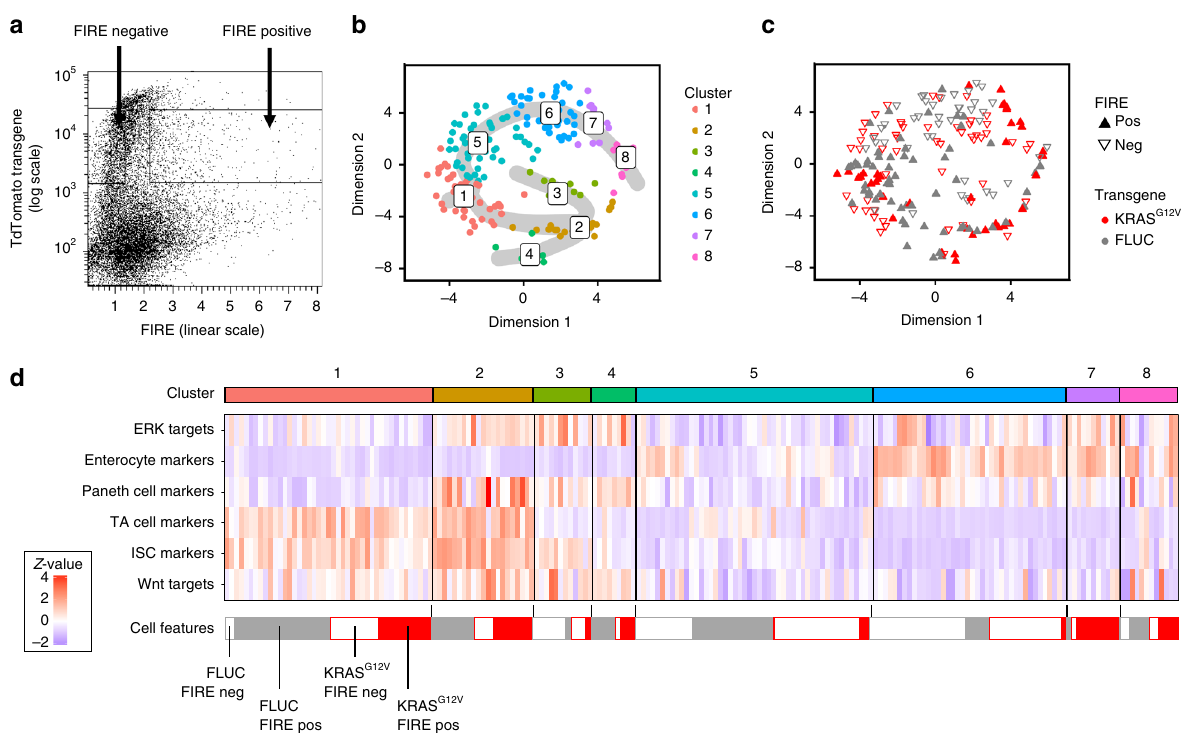
Fig. 5 Single-cell RNA sequencing reveals KRAS G12V -responsive and -unresponsive organoid cells. a Fluorescence-activated cell sort gates for FIRE- negative and -positive cells. b t-SNE visualisation colour-coded for eight clusters identi fi ed with k-means clustering. Differentiation trajectories starting at cluster 1 are shown as grey overlay. c t-SNE visualisation displaying colour codes for transgene and FIRE positivity. Filled upward-pointing triangles: FIRE- high; outlined downward-pointing triangles: FIRE-low. Red: KRAS G12V ; grey: FLUC. d Heatmap of z-transformed signature scores per cell for cluster cell type identi fi cation. Signature scores correspond to the number of expressed signature genes per cell normalised to gene detection rate and signature length. Blue: low target gene signature abundance; Red: high target gene signature abundance. Cluster colour codes are given above, and transgene and FIRE positivity codes are given below the